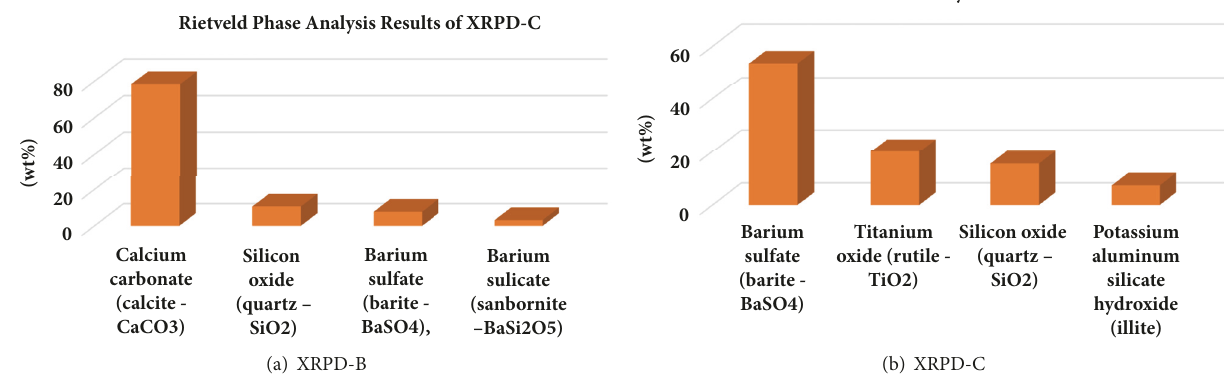
Figure 4: The Rietveld phase analysis results (i.e., wt% of the identified phases) of inorganic deposits (insoluble or nonhydrocarbon part) present in the (a) suction strainer for pumps (XRPD-B) and (b) water recycle pump